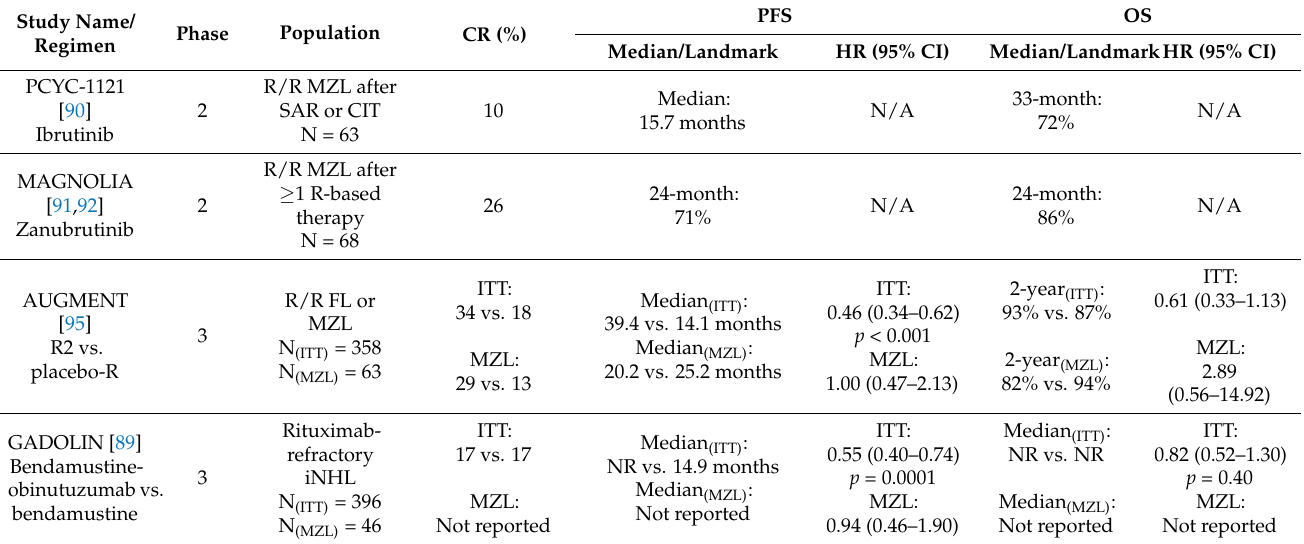
Table 2. Phase 2/3 prospective trials for treatment of relapsed/refractory advanced/symptomatic